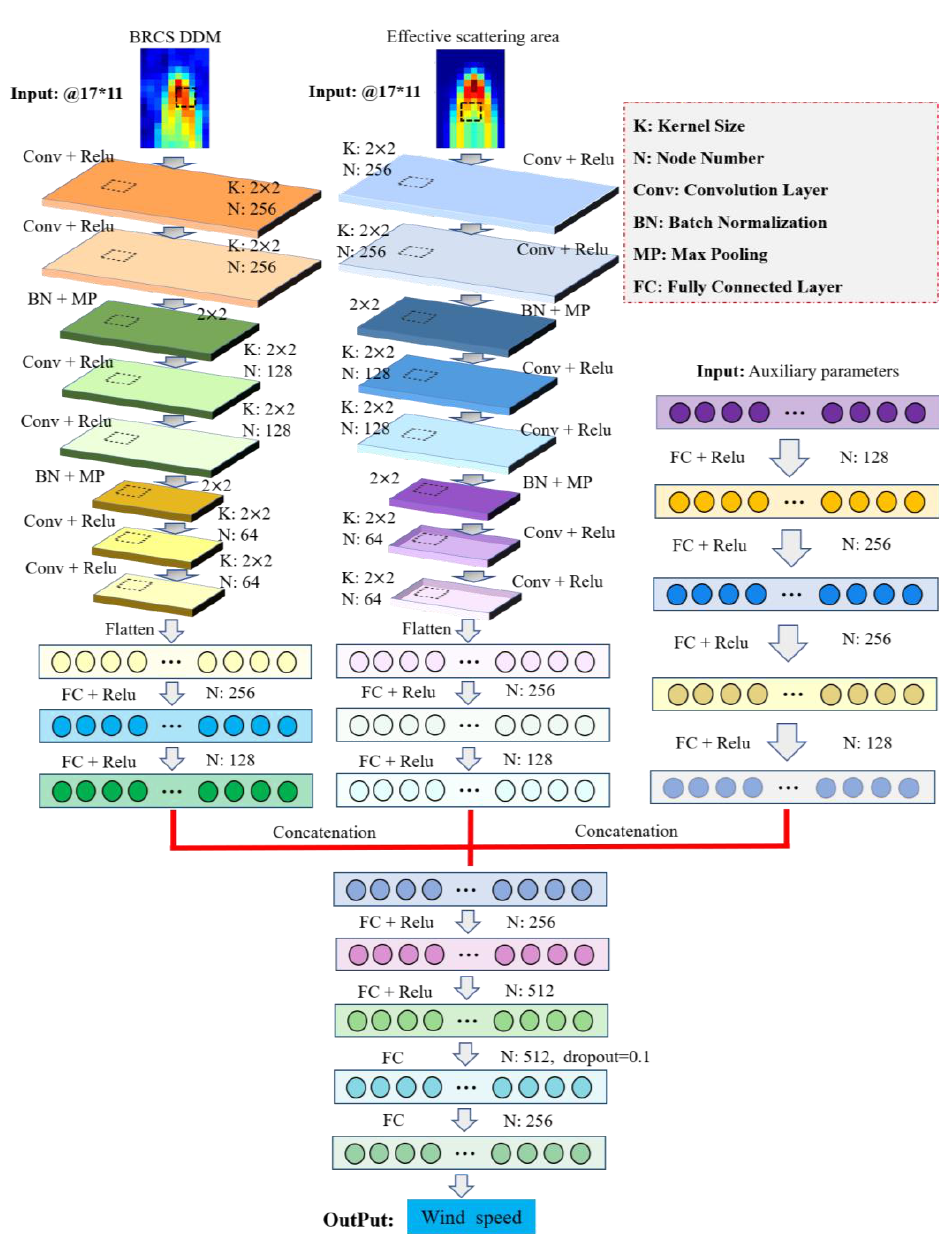
Figure 3. Architecture of GloWS-Net. Table 3. Input parameters of FCN, CNN and GloWS-Net models.